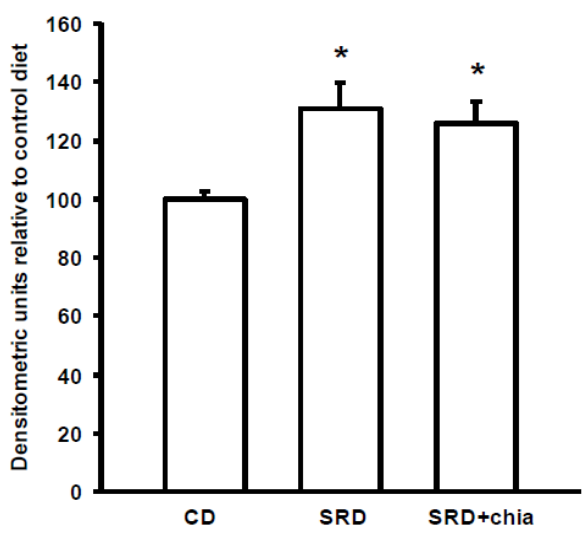
Figure 4. Heart protein mass level of PPAR α in rats fed a control diet (CD), sucrose-rich diet (SRD) or SRD + chia seed (SRD + chia). Top panel: a representative immunoblot of heart PPAR α of rats fed a CD, SRD and SRD + chia. Molecular marker is shown on the right. Lane 1 CD; lane 2 SRD; lane 3 SRD + chia. Bottom panel: densitometric immunoblot analysis of heart PPAR α protein mass level of rats fed CD, SRD or SRD + chia.. Values are mean, with their standard errors depicted by vertical bars (6 animals per group) and expressed as percentage relative to the control diet. * p < 0.05 SRD and SRD + chia vs. CD.